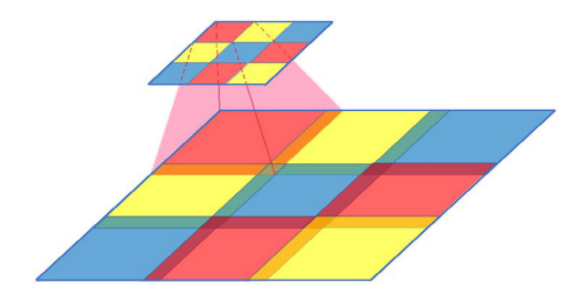
Figure 8. GAN network building images